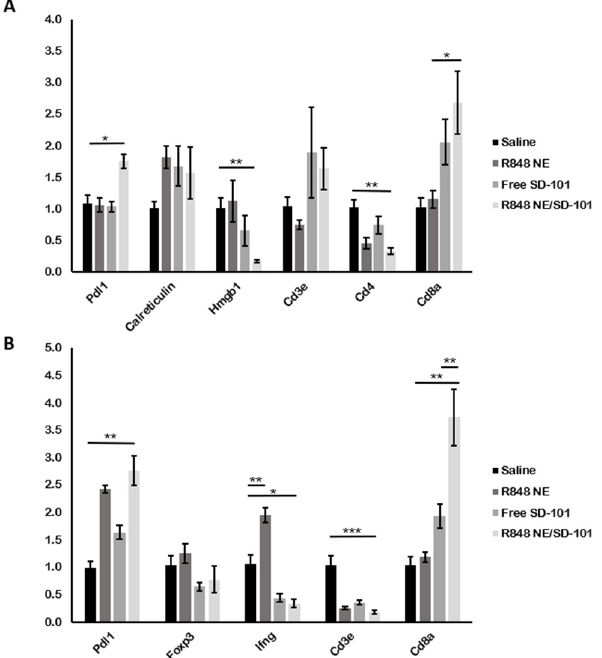
Figure 8. Gene regulation in tumor and spleen tissues from treated mice. ( A ) Pdl1, Calreticulin, Hmgb1, Cd3e, Cd4, and Cd8a expressions were determined by RT-qPCR in tumor tissues collected from C57BL/6N mice, and ( B ) Pdl1 , Foxp3 , Ifng , Cd3e , and Cd8a expressions were determined in spleen tissues collected from the mice within the same study. Data are presented as means ± SEM ( n = 3). One-way ANOVA: * p < 0.05, ** p < 0.01, *** p < 0.001.